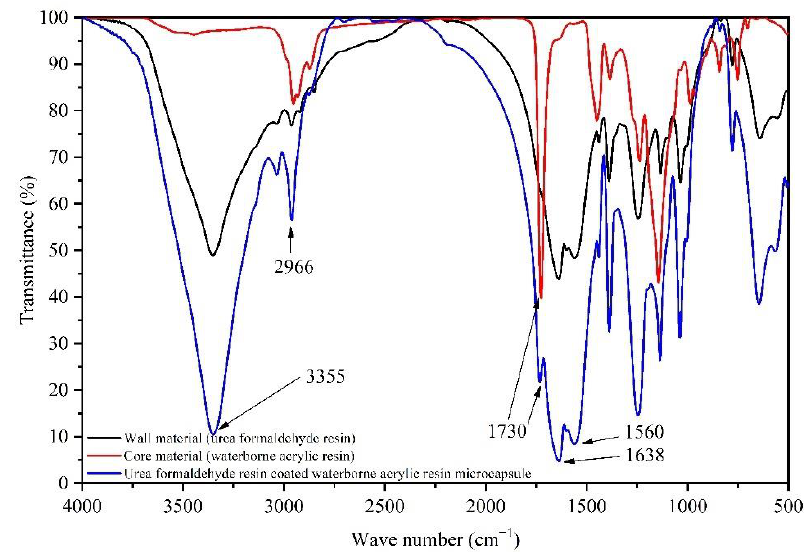
Figure 3. Infrared spectra of urea formaldehyde resin, waterborne acrylic resin and waterborne acrylic resin microcapsules.